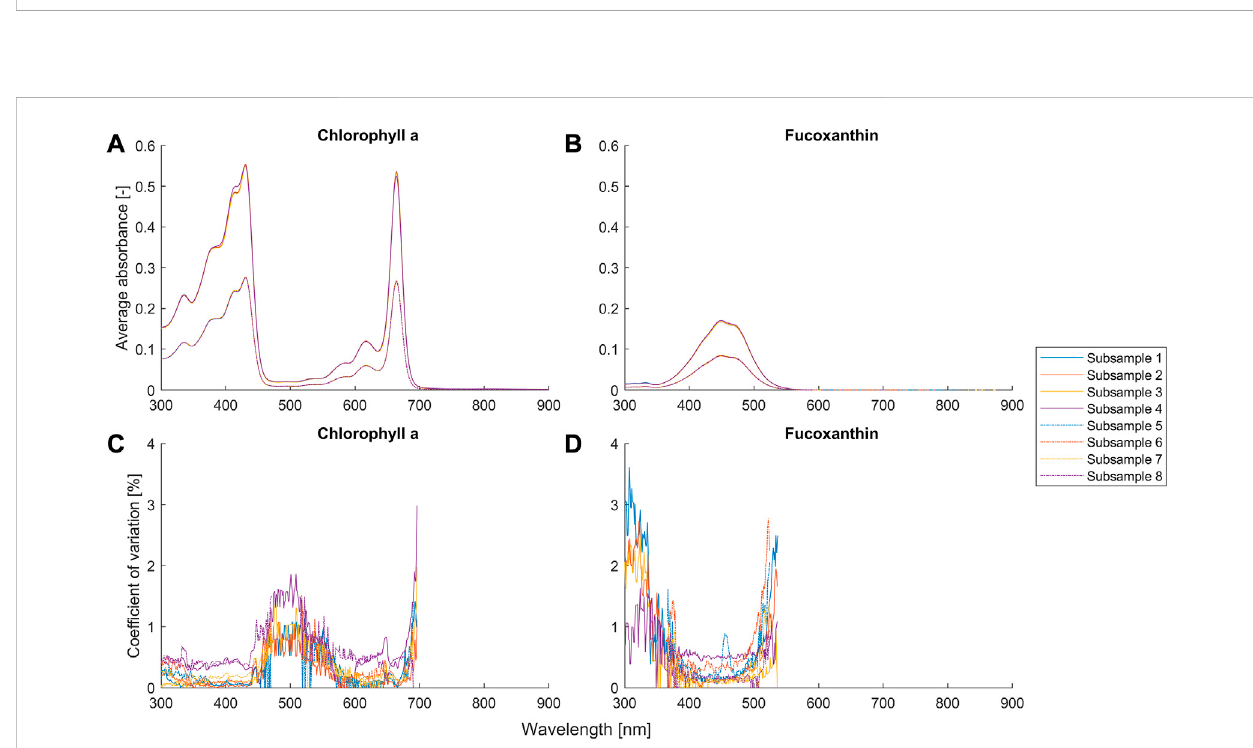
FIGURE 5 Average absorbance and coef fi cient of variance ( n = 3) for different setups (Table 2) of the suspensions of chlorophyll a and fucoxanthin. The coef fi cient of variation with an average absorbance smaller than 0.01 is removed and not shown in the fi gures, because the signal-to-noise ratio is too small and the re fl ected error becomes not